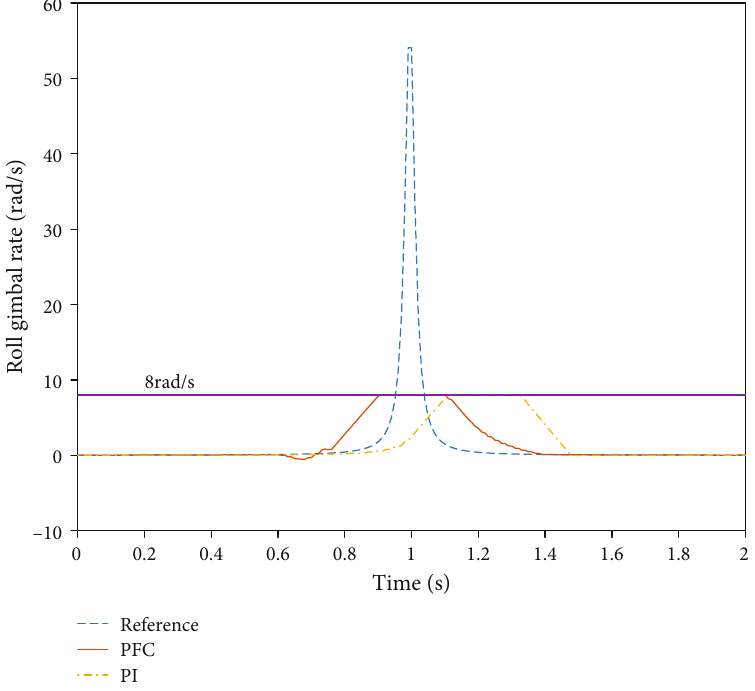
Figure 7: OG angle response of PFC and PI (1 deg, 60